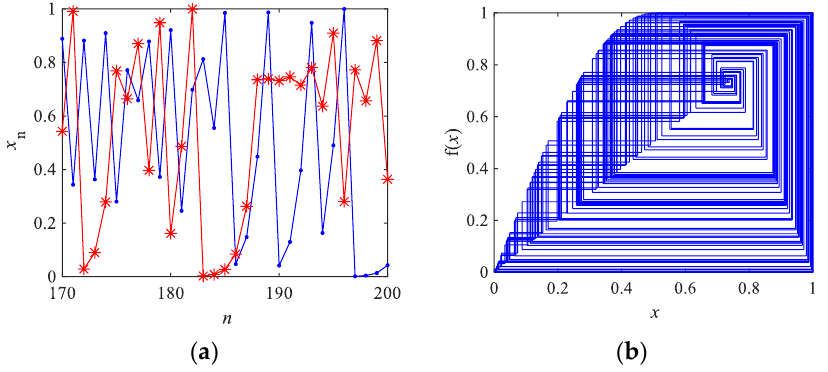
Figure 3. The time-series diagram and cobweb graph of system (1): ( a ) The time-series diagram, the blue dot data is generated from the initial value 0.23, and the red asterisk data is generated from the initial value 0.23+10 − 12 ; ( b ) the cobweb graph.